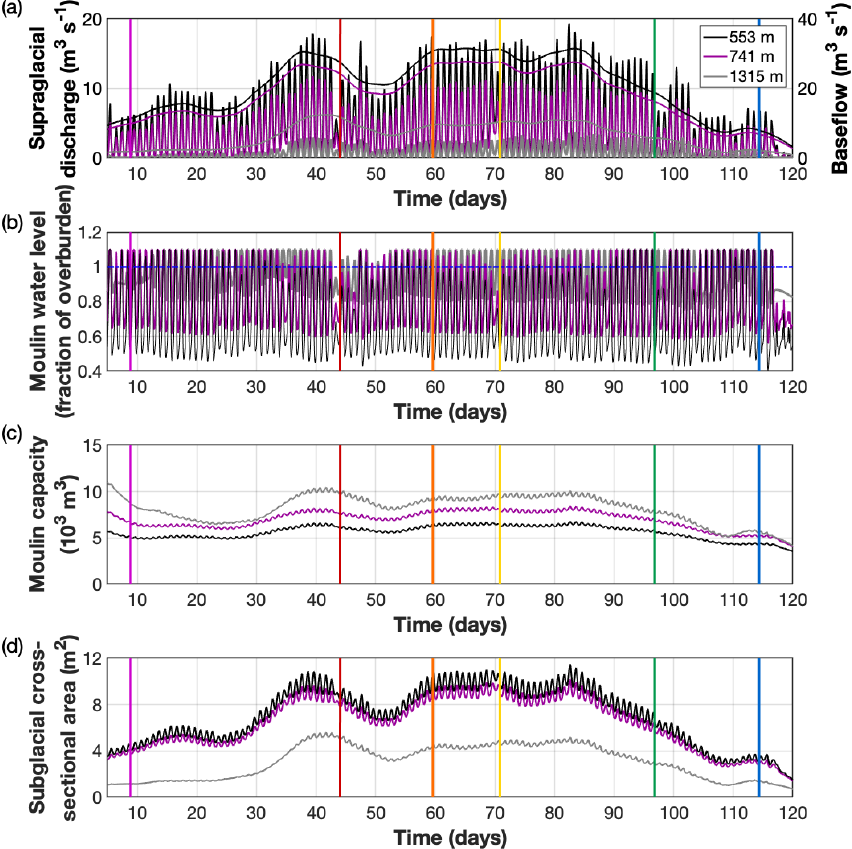
Figure 6. MouSh model runs with realistic supraglacial and ice conditions. The model runs are for a low-elevation Basin 1 ( H i = 553m; black lines), mid-elevation Basin 2 ( H i = 741m; purple lines), and high-elevation Basin 3 ( H i = 1315m; grey lines). (a) Supraglacial discharge into the moulin Q in and prescribed base flow Q base . (b) Moulin water level as a fraction of overburden. Note that the highest-elevation moulin exceeds the ice surface most days. (c) Moulin capacity, or the total moulin volume. (d) Subglacial channel cross-sectional area. Colored vertical lines indicate times in Fig. 7. Note x axes start on day